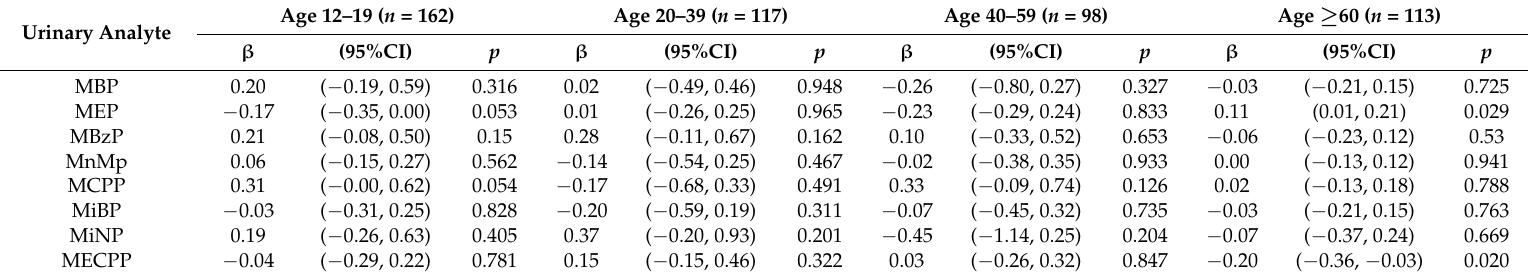
Note: The model had not been unadjusted by any covariant. Table 6. Associations between urinary phthalate metabolites and serum anti-Müller hormone level in males, NHANES 2003–2004 (adjusted). Urinary